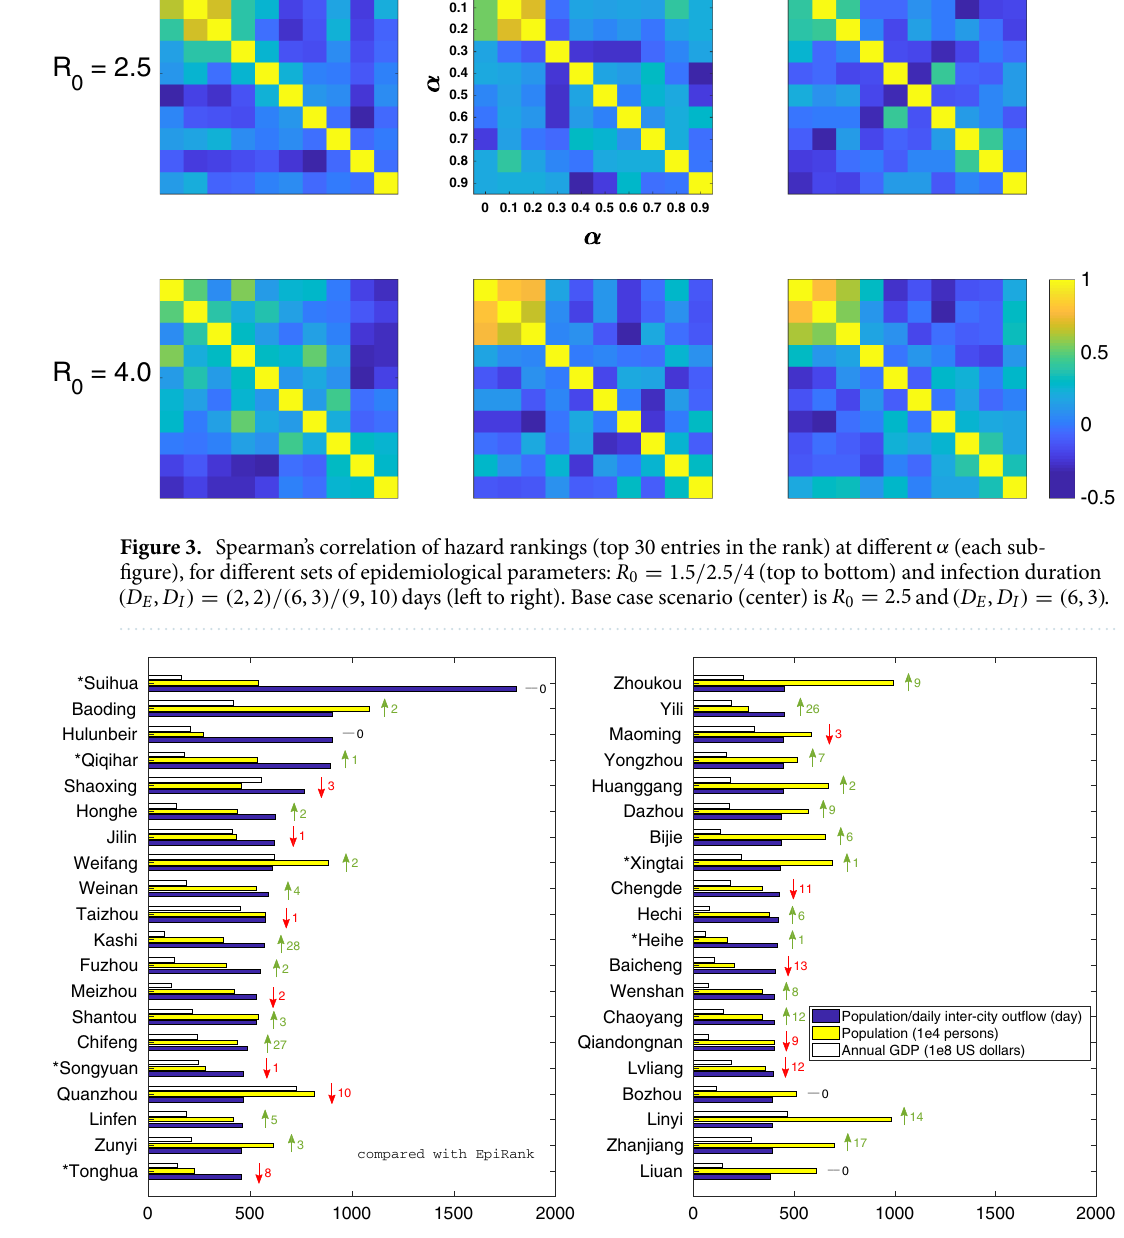
Figure 4. Local population/(daily) inter-city outflow as a simplified epidemic hazard indicator (showing top 40 cities in the ranking). Compared to EpiRank (results in Fig. 2), differences are marked with green, red or black arrows and numbers. This ratio is effective but less accurate than EpiRank in highlighting the six epicenters (with star marks). Shear population or annual GDP does not provide similar